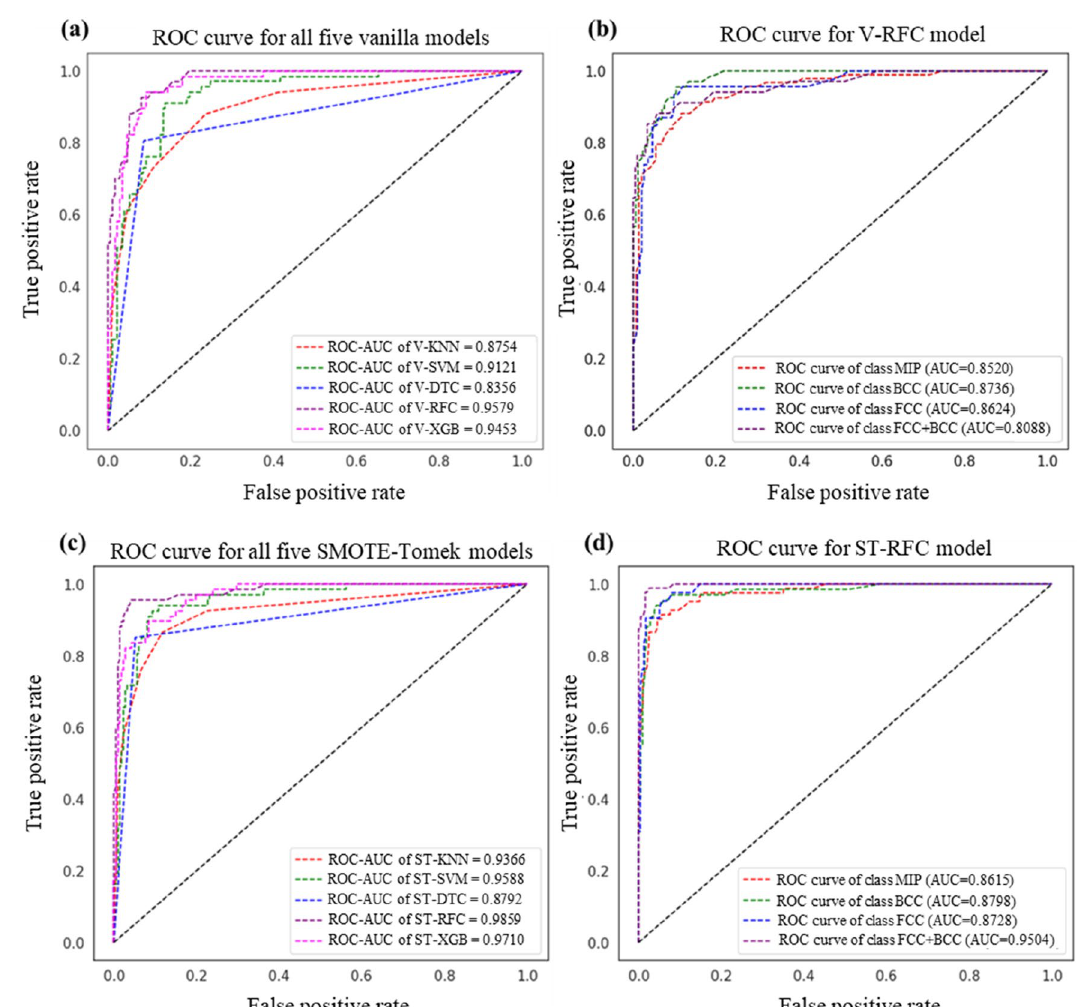
Figure 6. ROC-AUC scores for ( a ) five vanilla (base) models, ( b ) AUC score of each phase for the best vanilla model i.e., V-RFC model, ( c ) for all five SMOTE-Tomek links augmented model, ( d ) AUC score of each phase for the best SMOTE-Tomek links augmented model i.e., ST-RFC